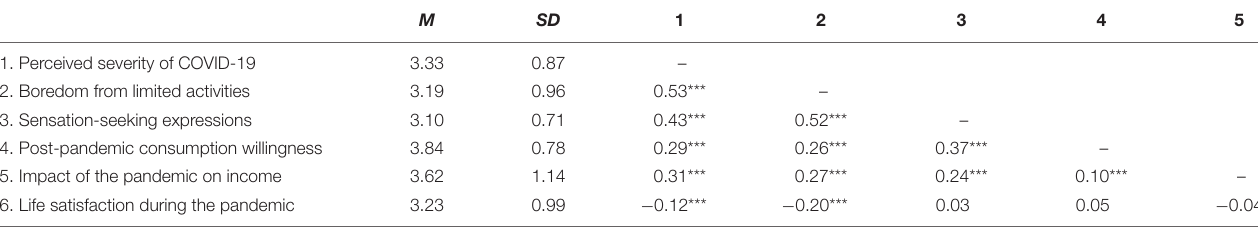
TABLE 1 | Pearson correlations between variables ( N = 1464).